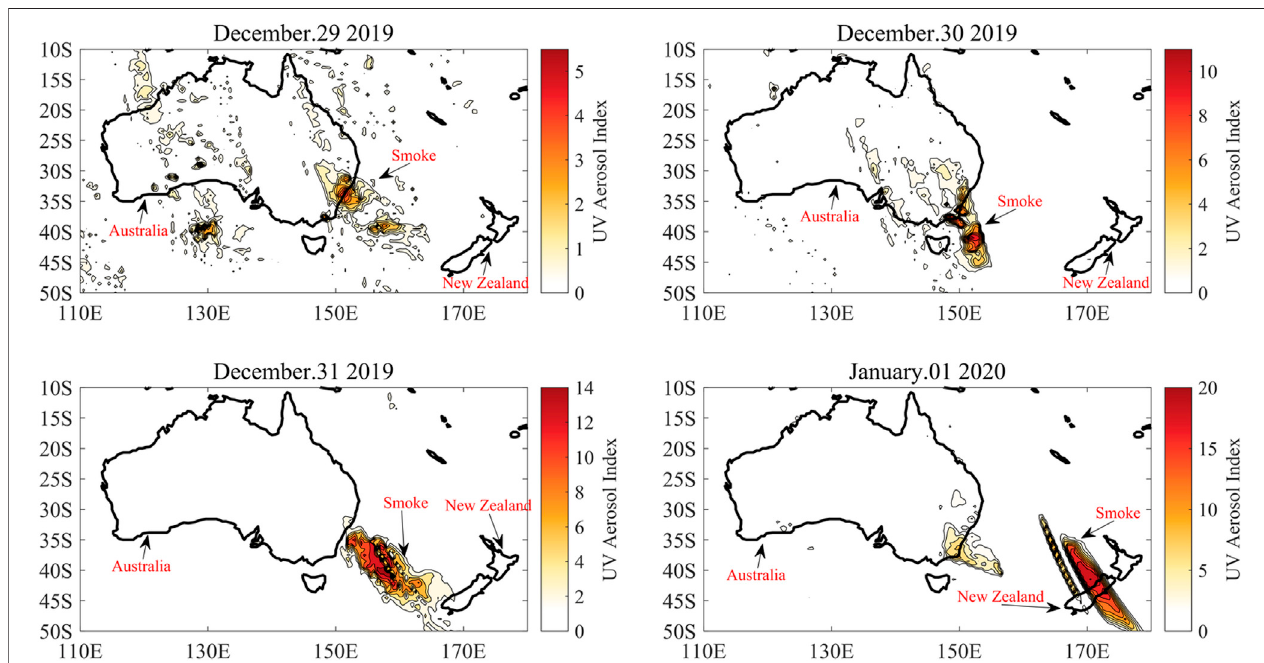
FIGURE 2 | UVAI of Australia (10 ° – 43 ° S, 114 ° – 152 ° E) on (A) December 29, 2019, (B) December 30, 2019, (C) December 31, 2019 and (D) January 01, 2020.